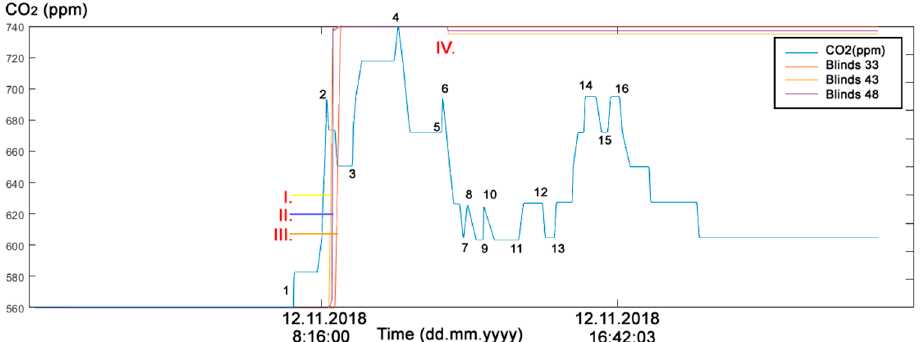
Figure 7. The reference (measured) CO 2 concentration course and Blinds course (12 November 2018) in room R203 in SHC for ADL monitoring. (1) arrival (12 November 2018 7:33:00), (2) departure (12